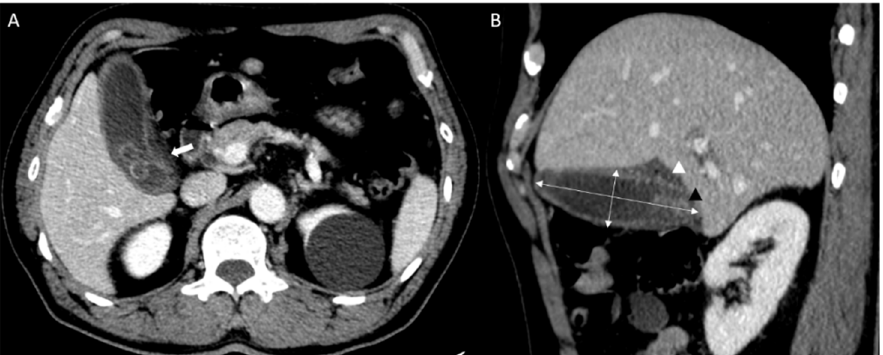
Figure 2. Abdominal computed tomography (CT) findings of acute cholecystitis in a 71-year-old with leukocytosis and right upper quadrant pain (( A ) axial scan, ( B ) sagittal scan). Abdominal CT results showing gallbladder (GB) distension (double arrow; GB width, 3.36 cm and GB length, 9.34 cm) with impacted GB stone (black triangle). It demonstrates fat infiltration (white arrow) and pericholecystic fluid collection (white triangle).